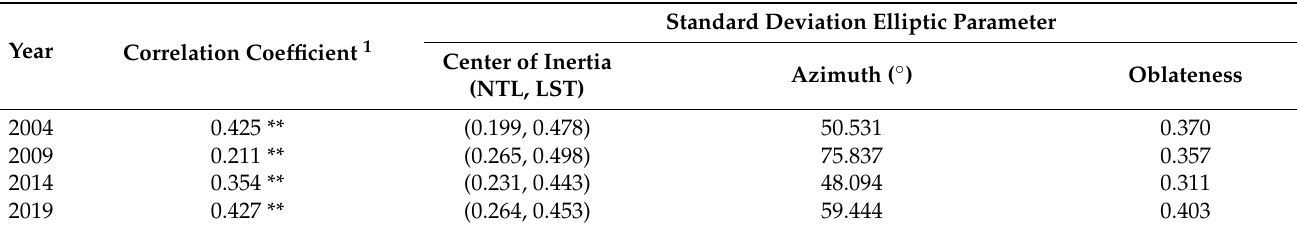
Table 8. Relevant NTL and LST parameters within the sixth ring road of Beijing from 2004 to 2019.